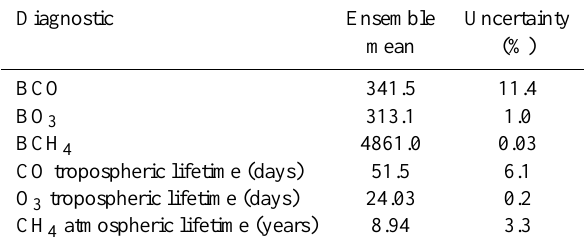
Table 5. Uncertainty in the global tropospheric burdens and atmo- spheric lifetimes of O 3 , CO and CH 4 for the year 2000 as calculated using the model ensemble. The burdens are given in Tg